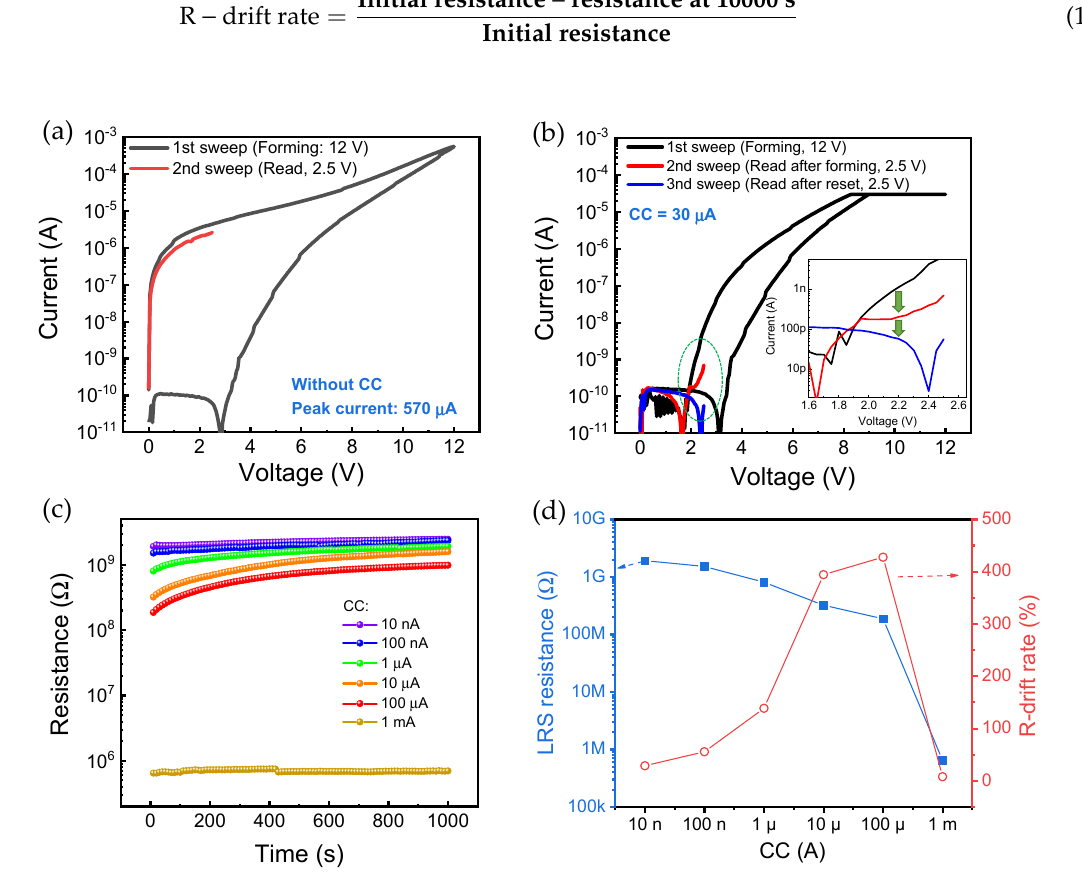
Figure 3. Volatile characteristics of Pt/HfO 2 /TaO x /TiN device. DC read sweep after forming voltage ( a ) without CC for high current level in the LRS and ( b ) with CC of 30 µA for low current level; ( c ) R-drift characteristics with different CCs from 10 nA to 1 mA; ( d ) LRS resistance and R-drift change as a function of CC.